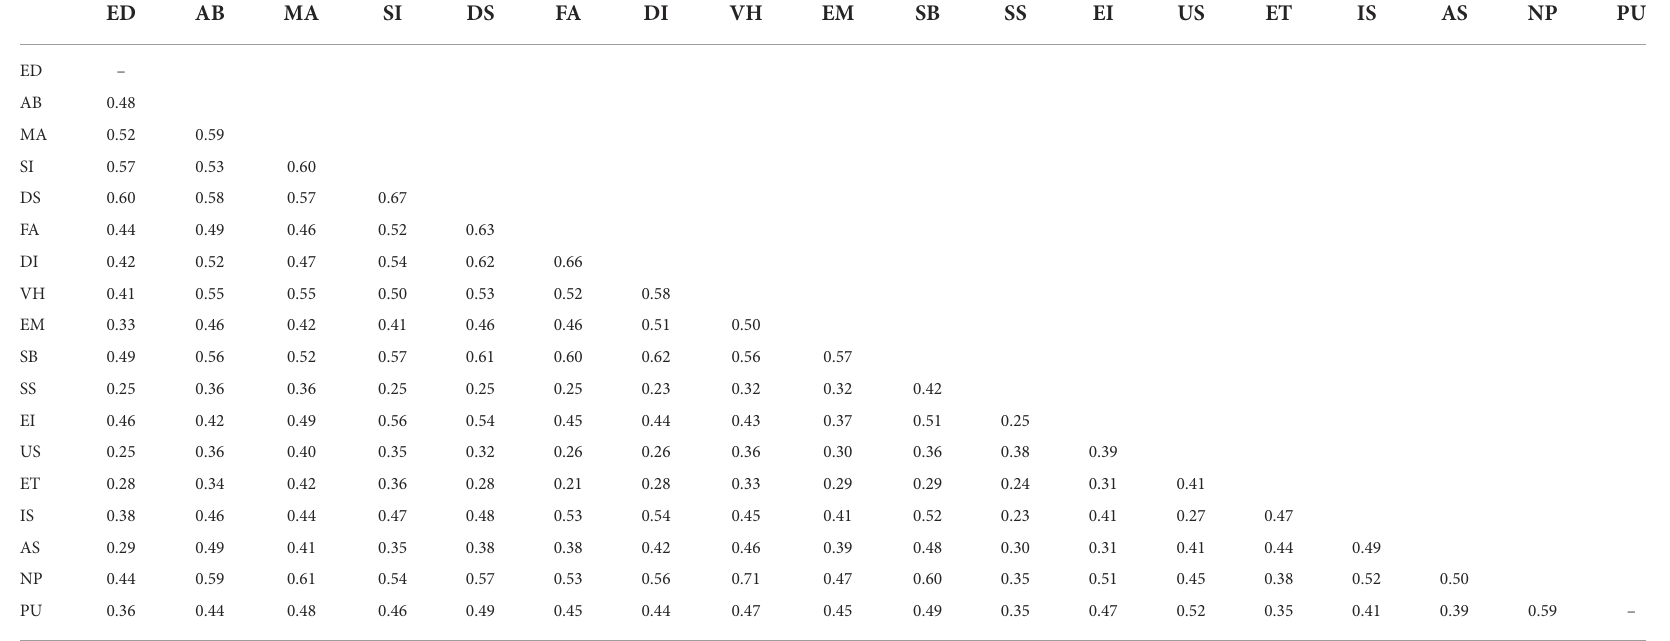
TABLE 3 Meta-analytically pooled correlation